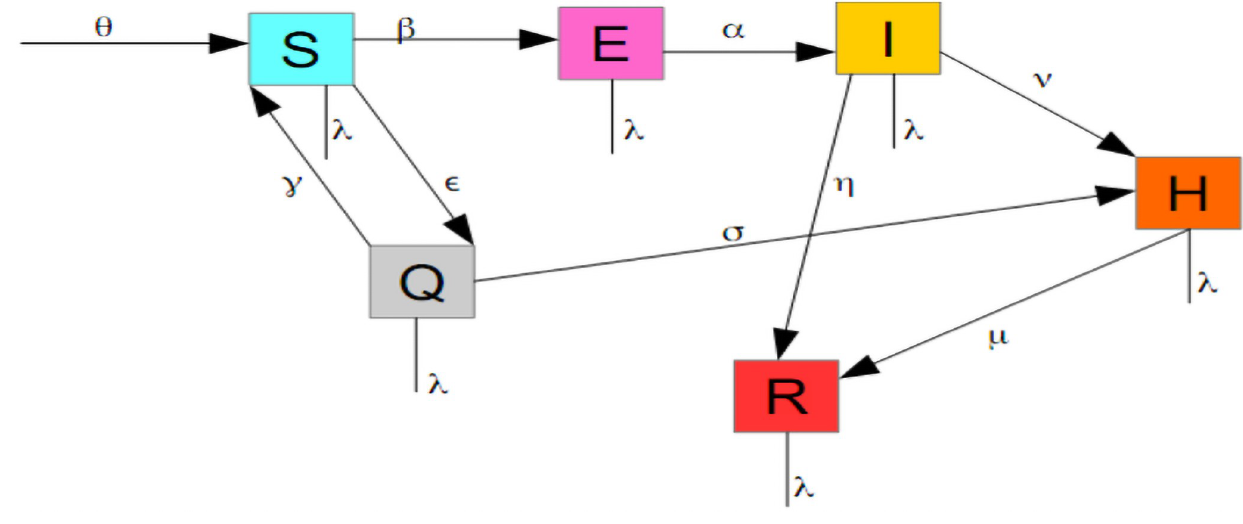
Fig 1. Structure of the proposed